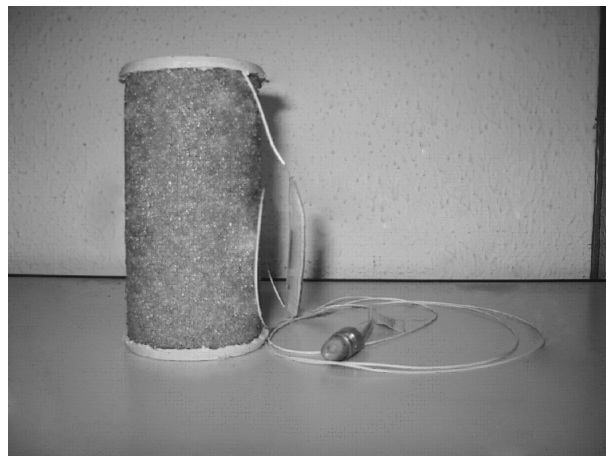
Figure 1. Specimen made with fresh sand.